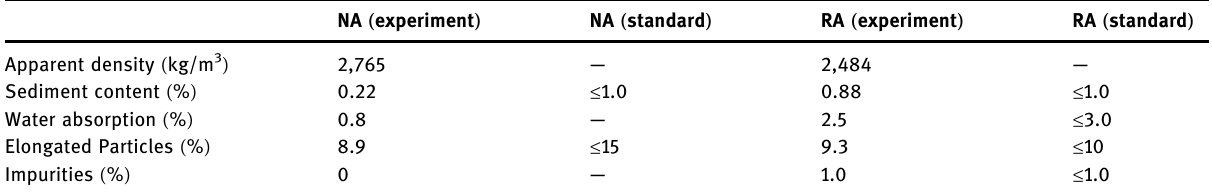
Table 2: Physical properties of coarse aggregates